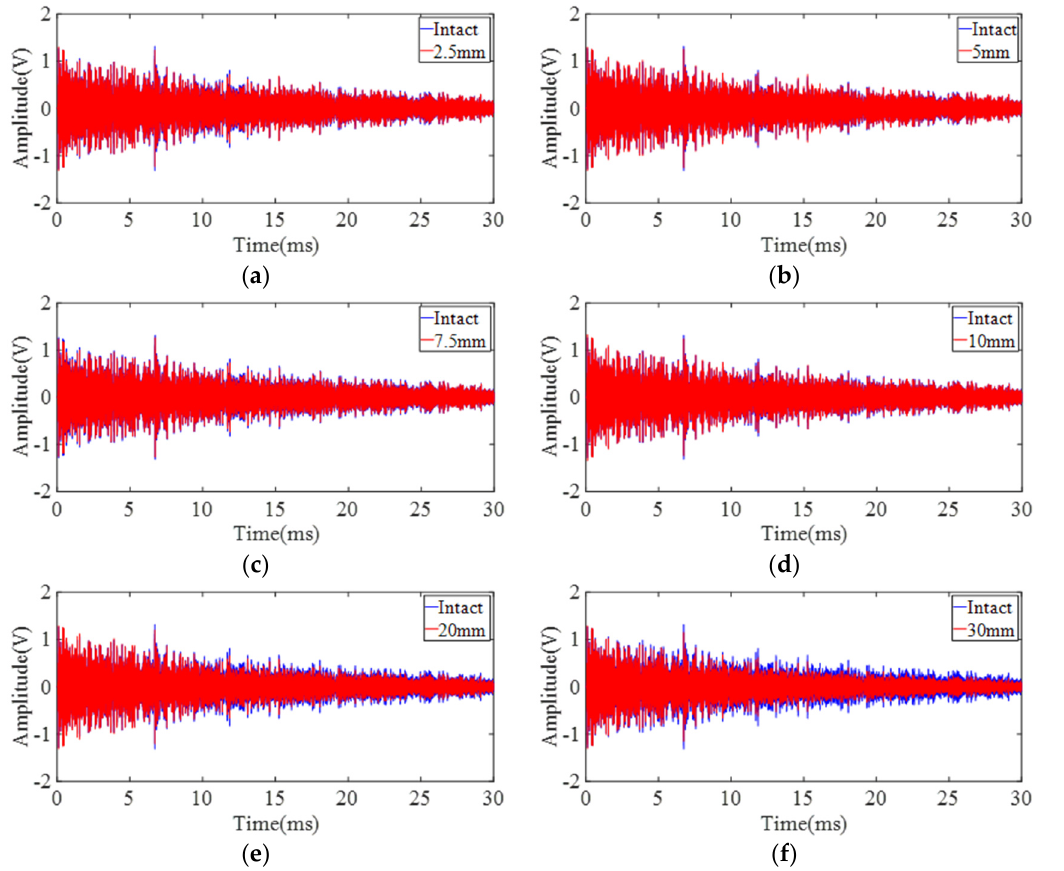
Figure 12. Signals obtained from six configurations on the left point of the direct sensing path (site 2): ( a ) 2.5 mm defect; ( b ) 5 mm defect; ( c ) 7.5 mm defect; ( d ) 10 mm defect; ( e ) 20 mm defect; ( f ) 30 mm defect.